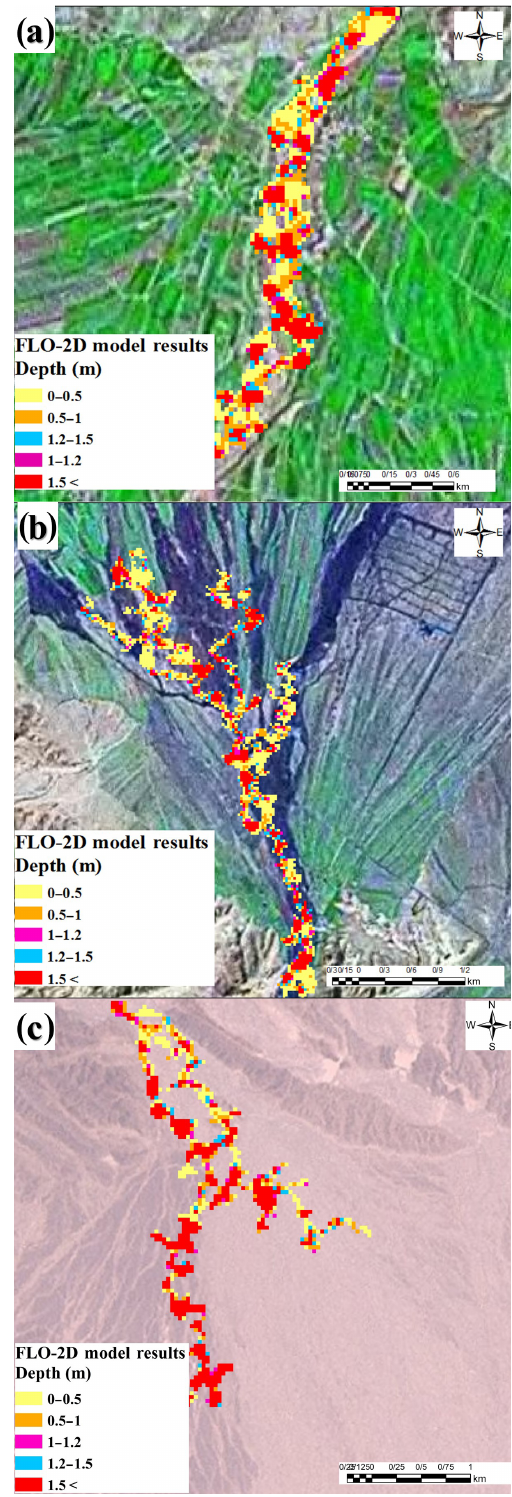
Figure 8. Flood depths results of the FLO-2D model for the (a) Fer- izy, (b) Ardak, and (c) Sarbaz